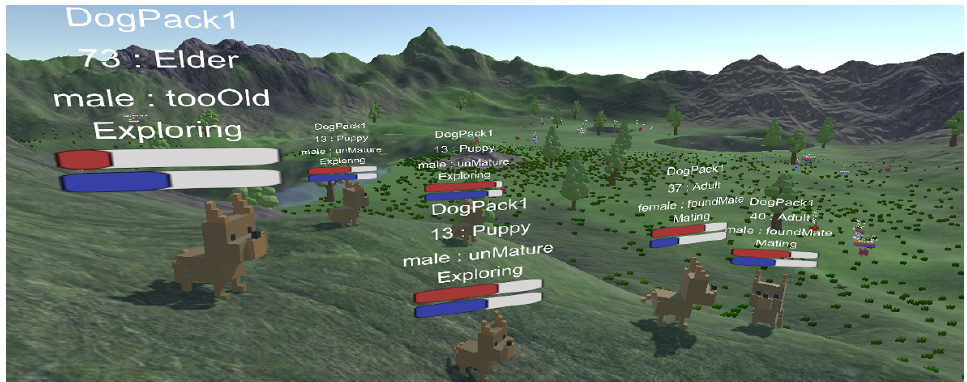
Figure 10. The animals can establish packs with other members of their own species. For each race, multiple packs can be formed during the